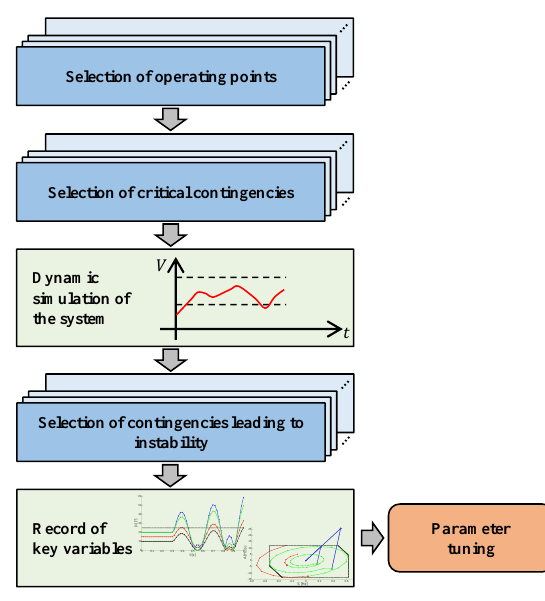
Figure 4. Flowchart of the methodology for parameter